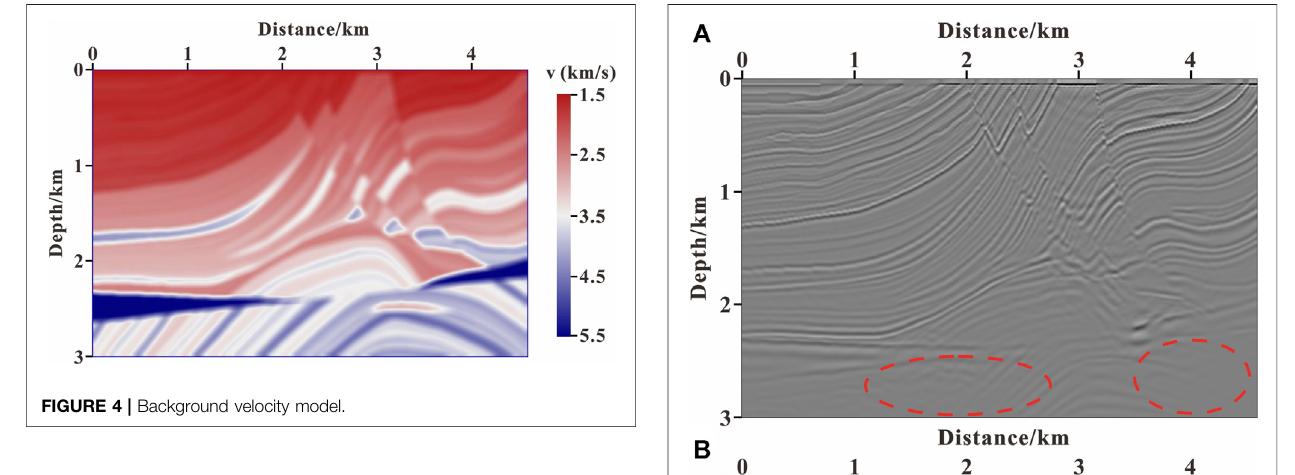
Frontiers in Earth Science |